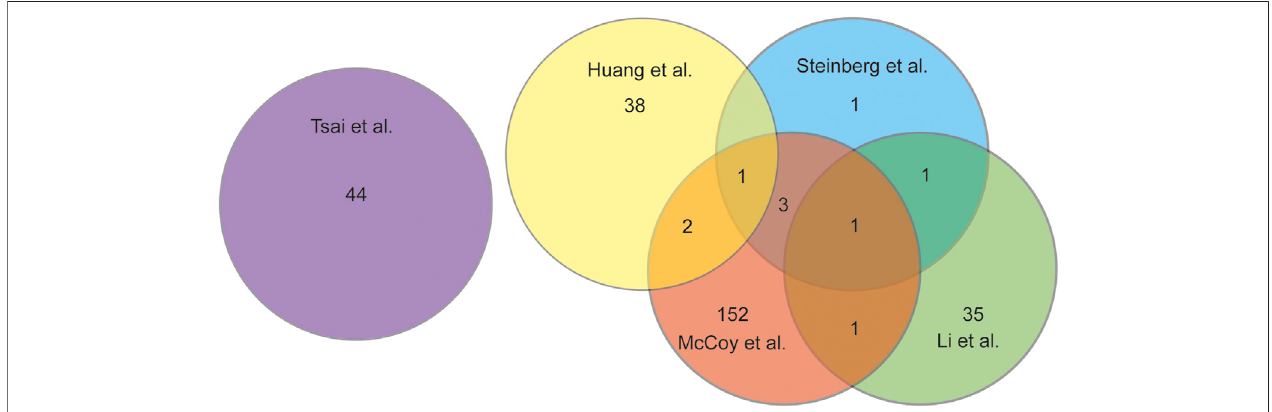
FIGURE 2 | Venn diagram analysing the overlap of DEGs discussed in each study chosen for this review.